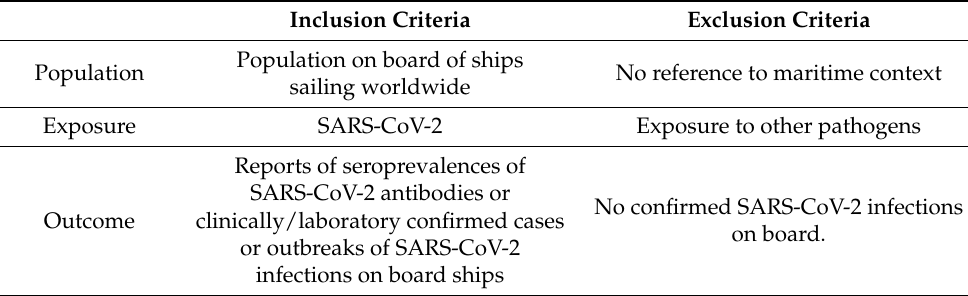
Table 1. Inclusion and exclusion